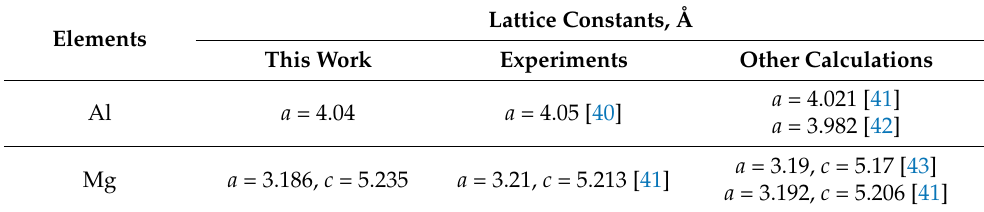
Table 1. Lattice constants of fcc Al and hcp